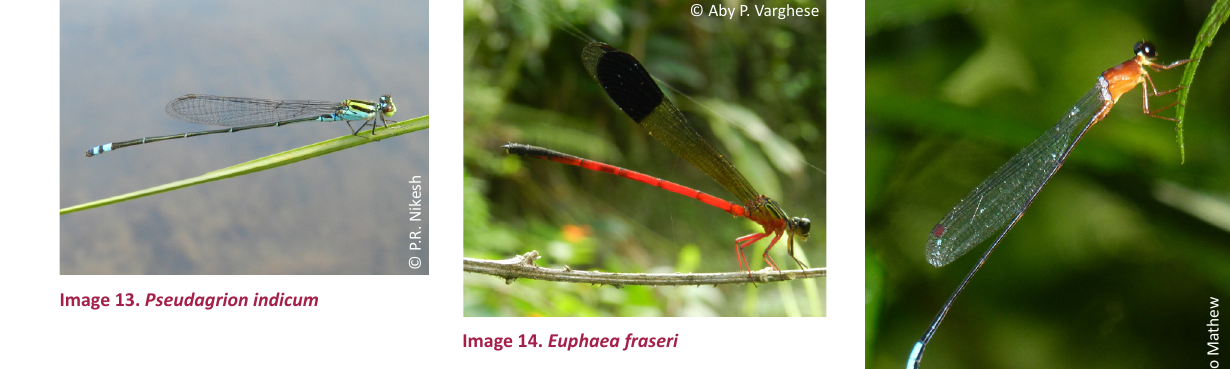
Image 14. Euphaea fraseri